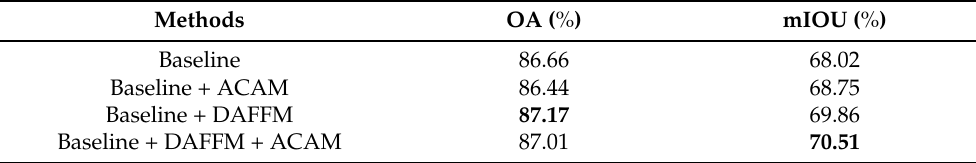
Table 1. Evaluation of land cover classification accuracy on ISPRS 2D Semantic Labeling Vaihingen data [35].